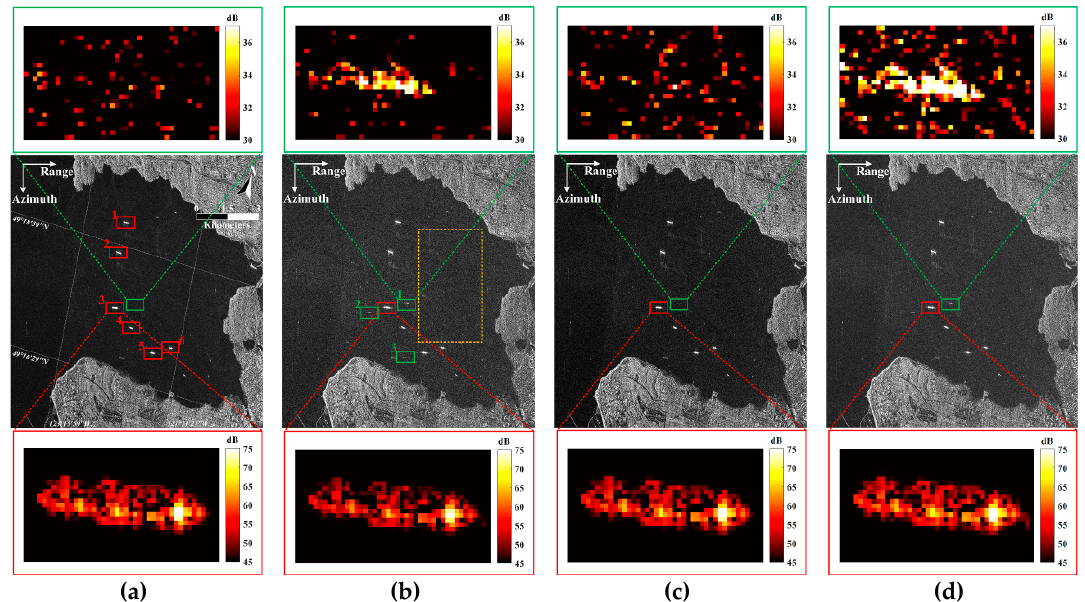
Figure 18. Simulation based on a real SAR raw data from Radarsat-1. All images were quantized with the same method. ( a ) Imaging result for the original data. ( b ) Imaging result for the saturated data with a 25% saturation factor. This image contained a series of false targets beside ships and considerable noise in sea areas. ( c ) The reconstructed result with the proposed method. ( d ) The reconstructed result with power loss compensation (PLC factor 1.67). Table 8. RAIs of the real targets in red boxes.